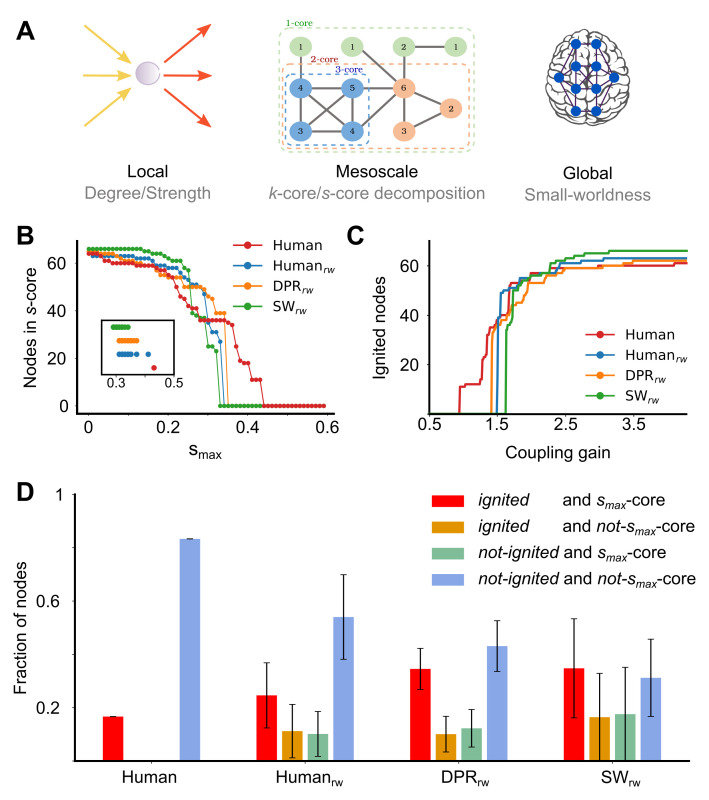
Ignited cortical areas perfectly match the weighted core of the Human at the ignition point.(A) A scheme of the local, mesoscale and global level of organization of the network. At left, the local level is represented by the sum of inputs and outputs of a cortical area. At the middle, the mesoscale level is measured with the core decomposition, composed by shells of incremental within-connected (or strongest) nodes. In the cartoon, blue nodes belong to the 3-core, orange to the 2-core shell and green to the 1-core shell. The number within each node denotes its degree. At the right, the global level considers the small-worldness, the integration and segregation ratio of the whole-network. (B) The s-core decomposition of Human (red), Humanrw (blue), DPRrw (orange) and SWrw (green). The y-axis shows the number of nodes in the shell, whereas the x-axis shows the smax of each shell. Only one example for each type of wSCs is shown in the main plot. The inset shows the smax for all the networks used. (C) Number of ignited (Ri > 5) nodes in the network as a function of coupling gain G and for high ICs, showing the Human and one example of each wSC. (D) Fraction of nodes which are ignited (red, orange) or not-ignited (green, blue) at the G- bifurcation, and that belong to smax-core (red, green) or not (orange, blue).